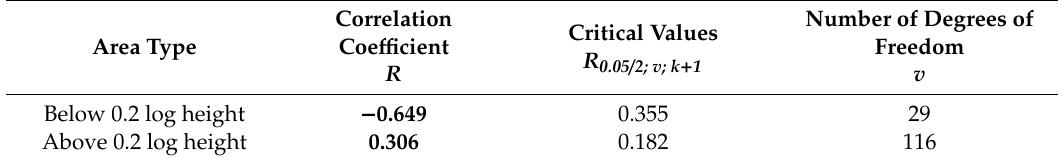
Table 10. Two-sided tests of significance of correlation coefficients between the average density of birch wood and its location at trunk height below and above 0.2 log height (at significance level p = 0.05).